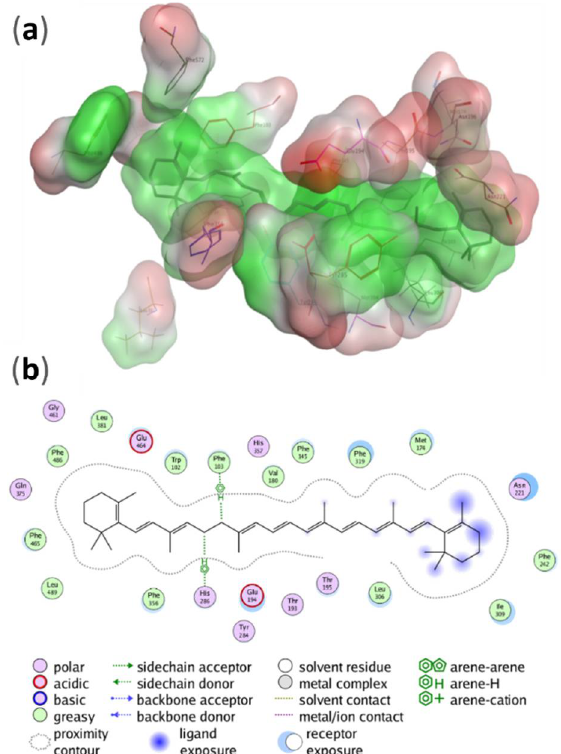
Figure 7. ( a ) Potential energy surface over the β -carotene and the BCO2 residues with which it interacts, according to PLIF analysis. With green the hydrophobic areas and with red the hydrophilic areas. ( b ) Two-dimensional representation of the interactions established by β -carotene within the BCO2 catalytic site. Only the residues contacting the carotenoid at less than 4.5 Å distance are